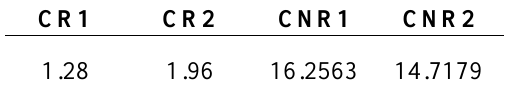
Table 4. Testing Results of CR1, CR2, CNR1, and CNR2.